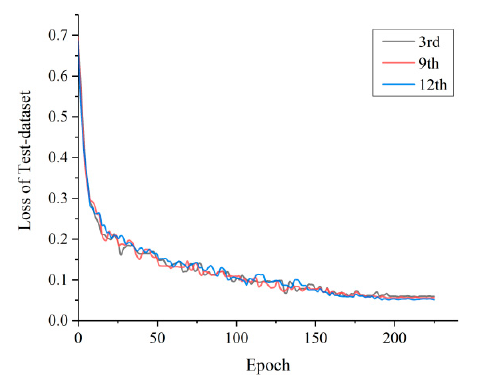
Figure 10. Loss curves of the 3rd, 9th, and 12th training set.